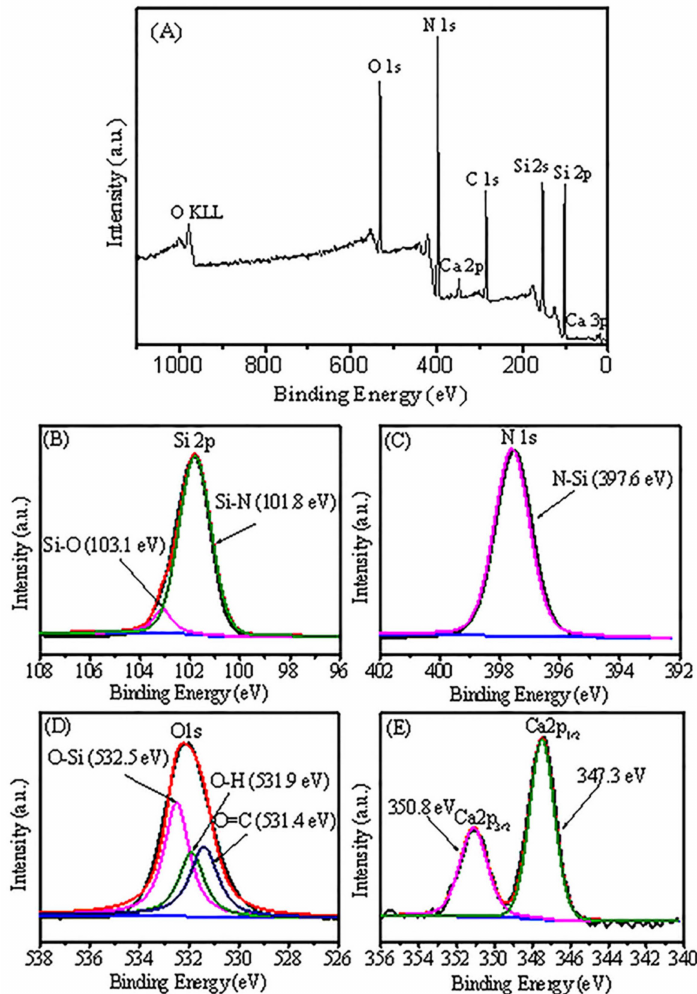
Figure 3. X-ray photoelectron spectroscopy survey ( A ) and X-ray photoelectron spectroscopy spectra of Si ( B ), N ( C ), O ( D ), and Ca ( E ) elements in the Si 3 N 4 particles obtained at 1300 ◦ C under NH 3 atmosphere with 4 wt% of CaF 2 additive.